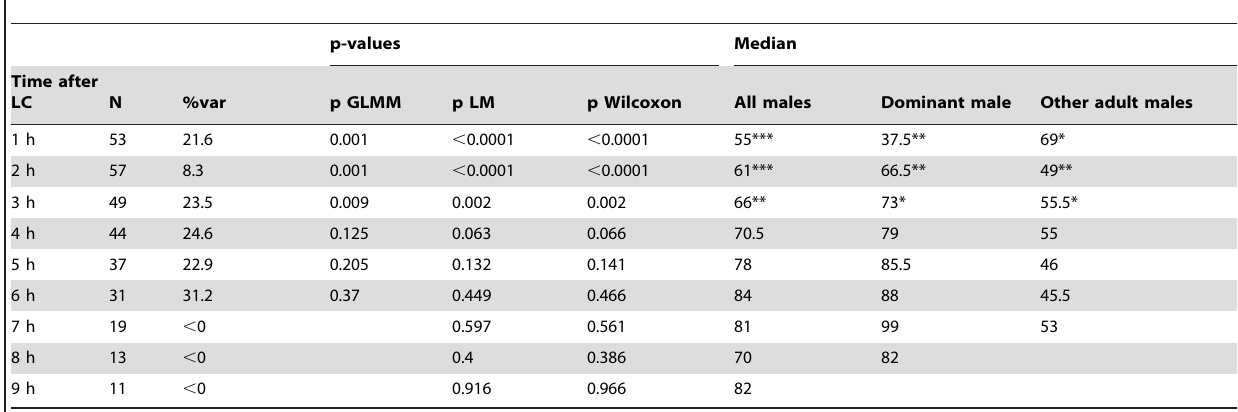
Table 2. Deviation angles between long call direction and travel direction after the first elicited long call of a day.